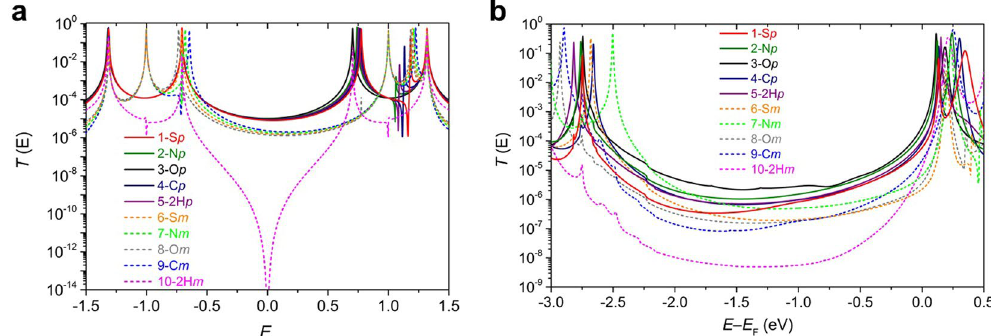
Figure 6. Transmission coefficients. Results for the tight-binding (Hückel-model) transmission coefficients ( a ) obtained using the parameters in Supplementary Table 5. The transmission coefficients ( b ) obtained for electrodes with adatoms (see Fig. 7b) using density functional theory combined with Gollum.